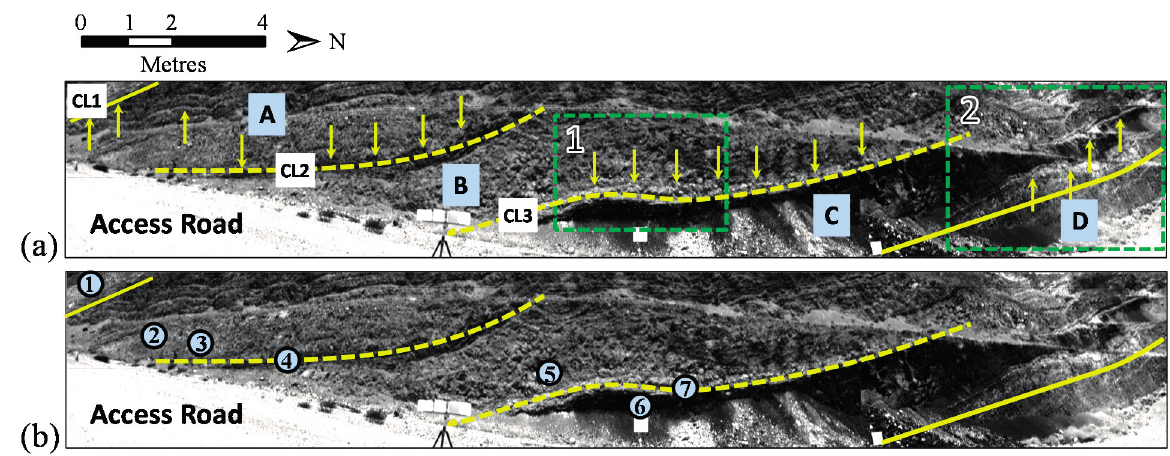
Figure 1. Images showing context of geological units within the mine face. ( a ) Location of observed clay shale bands (shown as arrows) and their relationship to geological units on the mine face: Major layers of clay which mark the boundaries of geological units are indicated (CL2, CL3) by dotted yellow lines. Clay layer 1 (CL1) extends beyond the borders of the image and its boundary with geological unit “A” is shown as a solid yellow line. Banded Iron Formation (A and D); Whaleback shale (B), Black shale (C). See Table 2 for details. Geological units not delineated by discrete layers of clay are shown as solid lines. Spatial image subsets (Subsets 1 and 2) used in this study are shown by the dashed green rectangles; ( b ) Location of plots from which samples taken for XRD analysis and laboratory